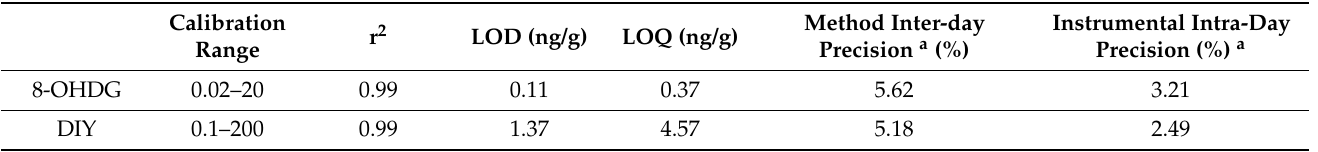
Table 2. Calibration curves, limits of detection (LODs) and quantification (LOQs), and precision for the determination of 8OHDG and DIY.